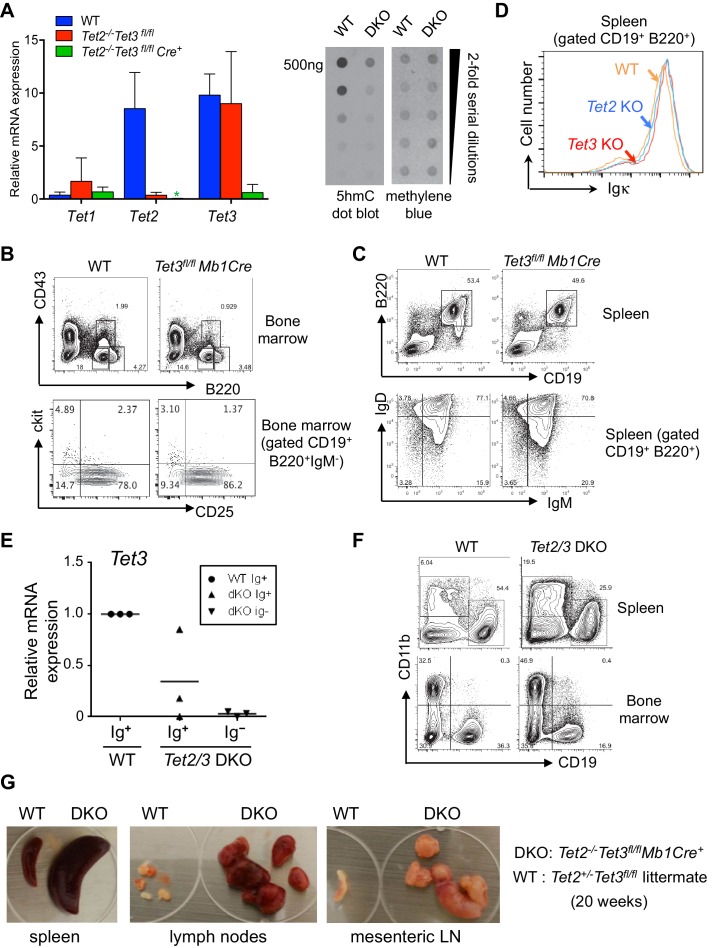
Tet2 and Tet3 are redundantly required for B cell development and BCR expression.(A) Right, floxed Tet3 alleles are efficiently deleted in Tet2-/-Tet3fl/fl pro-B cells transduced with Cre-IRES-GFP retrovirus. Expression of Tet1, Tet2 and Tet3 mRNA in Cre+ (GFP+) WT and Tet2-/-Tet3fl/fl pro-B cells was measured by real time qRT-PCR. Left, genomic DNA was isolated from WT and Tet2/3 DKO pro-B cells and the overall level of 5hmC was detected by anti-hmC dot plot. (B) B cell development in the bone marrow is normal in the absence of Tet3. Tet3fl/fl Mb1-Cre mice (12 week-old) were analyzed. Shown are representative FACS plots for B220 and CD43 expression in the bone marrow (top panel) and c-kit and CD25 expression in the CD19+B220+IgM- bone marrow cells (lower panel). (C) Normal B cell compartment in the periphery of Tet3fl/fl Mb1-Cre mice. As in (B) splenocytes were analyzed for expression of CD19 and B220 (upper panel); IgM and IgD expression of CD19+B220+ B cells (lower panel). (D) Normal expression of cell surface Igκ in splenic B cells from Tet2-KO or Tet3-KO. Cell surface Igk was analyzed by flow cytometry as in Figure 2A. (E) Ig+ cells from Tet2/3 DKO mice have variable levels of residual Tet3 mRNA expression. Ig+ (IgM+IgD+) or Ig- (IgM-IgD-) splenic B cells (CD19+B220+) were sorted and Tet3 expression was determined by real-time qRT-PCR. (F) Compared to WT mice, Tet2/3 DKO mice have higher frequencies of myeloid cells in the spleen and bone marrow. Shown are representative flow cytometry plots of CD19 and CD11b staining. Frequencies of B cells (CD19+CD11b-) and myeloid cells (CD19-CD11b+) are indicated. (G) Formation of splenomegaly and lymphadenopathy in Tet2/3 DKO mice. Lymph nodes and spleen from a representative Tet2/3 DKO mouse and littermate control (Tet2+/- Tet3fl/+) at 20-week of age are shown.